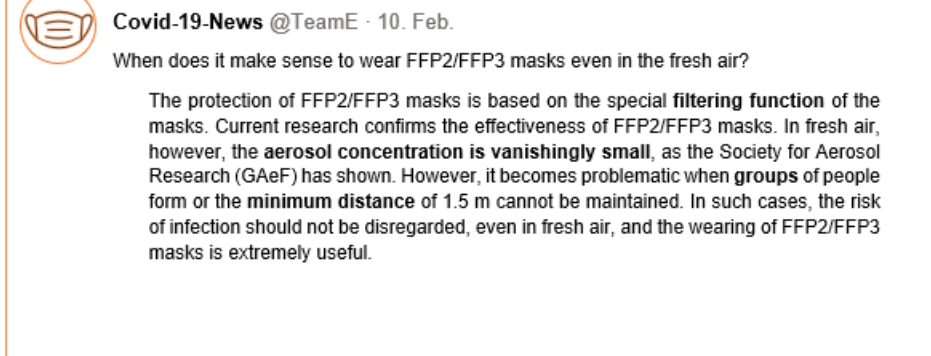
Figure A2. Scientific Posting Team E. Note. Predictor media content: scientific Posting Team E. Orig- inally presented in German. Translation: “Wann.ist es sinnvoll, FFP2/FFP3-Masken auch an der